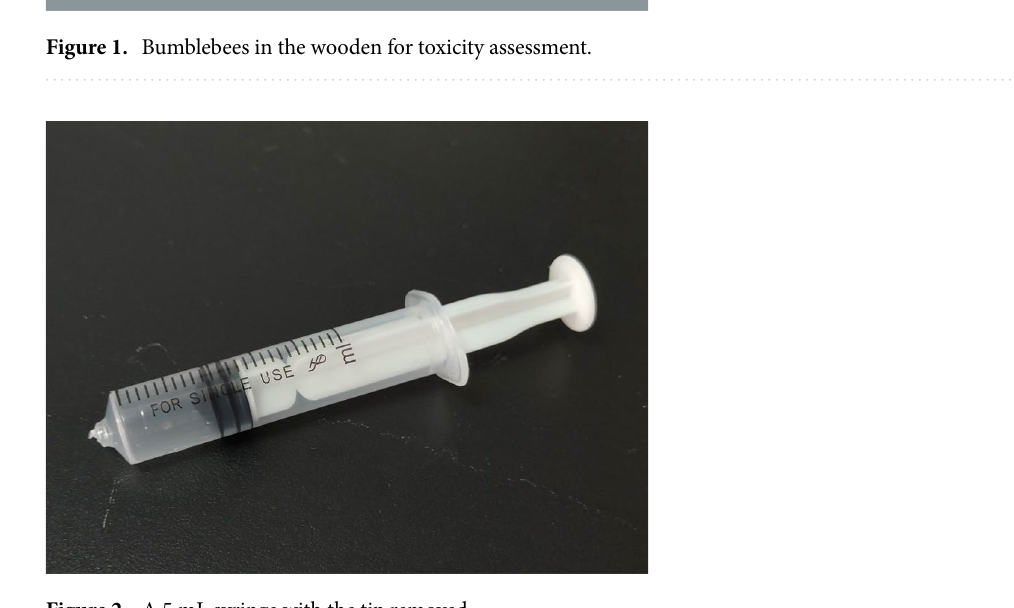
Figure 2. A 5 mL syringe with the tip